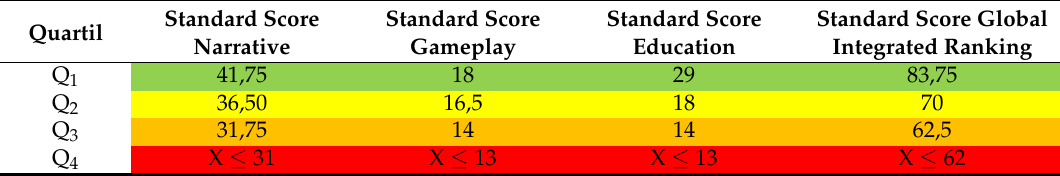
Table 7. Standard scores by